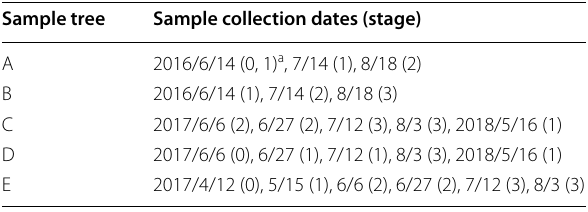
a Stages 0 and 1 were observed in different parts of the same block sample